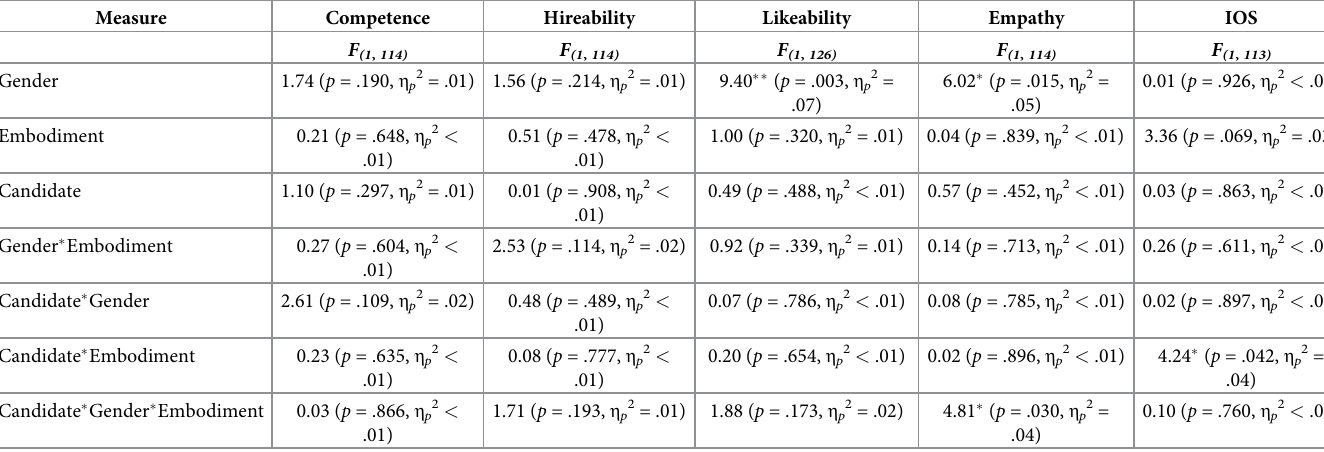
Table 10. Mixed ANOVA models for candidate ratings following vr perspective